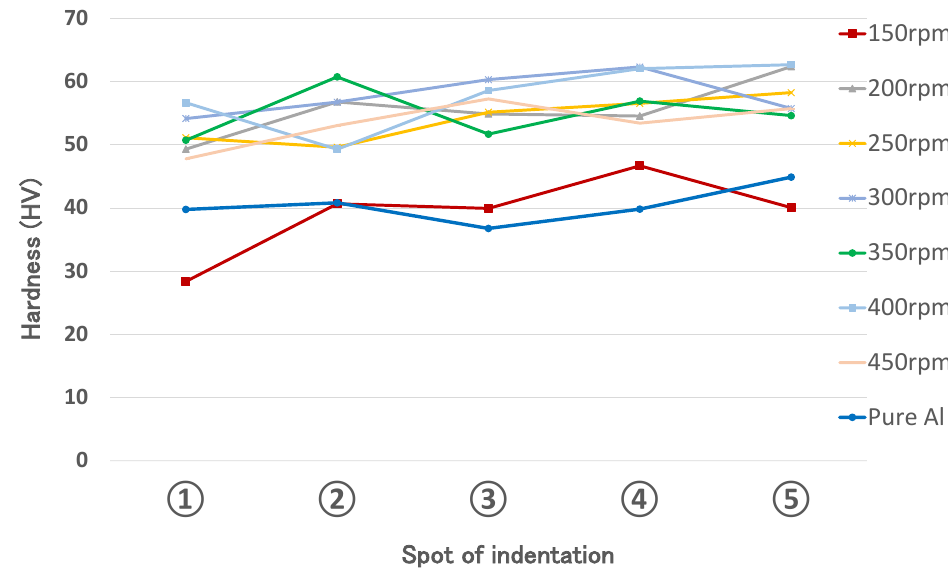
Figure 7. Vickers hardness on the cross sections for samples of FGMs with different rotation speeds. Centrifugal directions correspond to ①⇒⑤